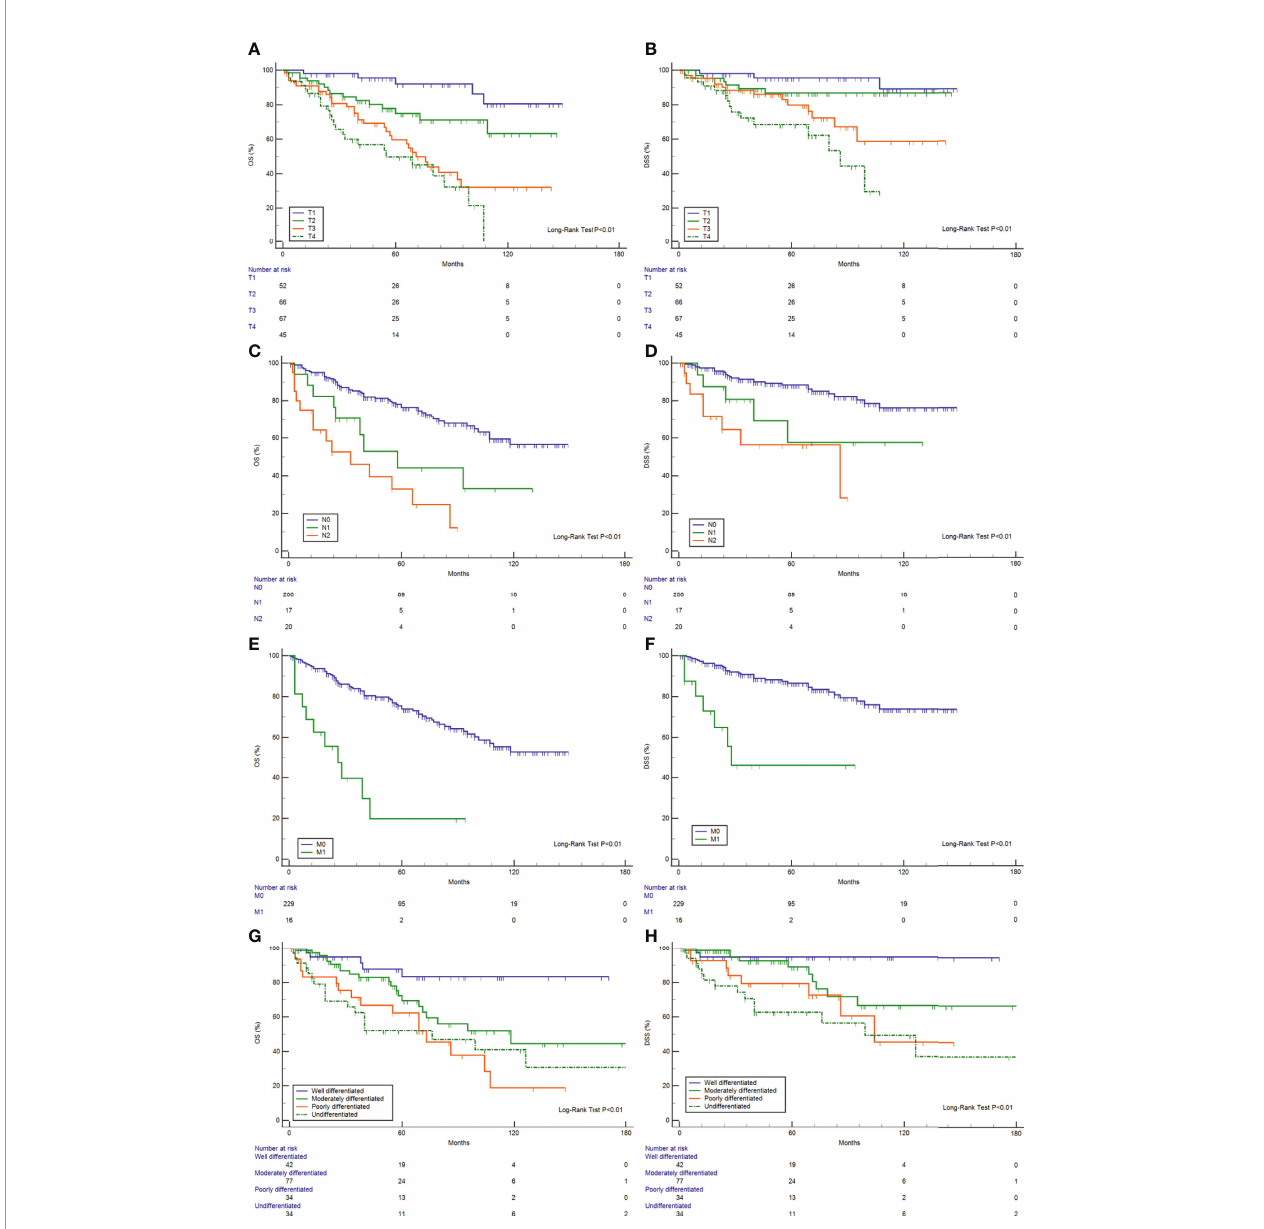
FIGURE 2 | OS and DSS analysis. (A) OS and T category; (B) OS and N category; (C) OS and M category; (D) OS and pathological grade; (E) DSS and T category; (F) DSS and N category; (G) DSS and M category; and (H) DSS and pathological